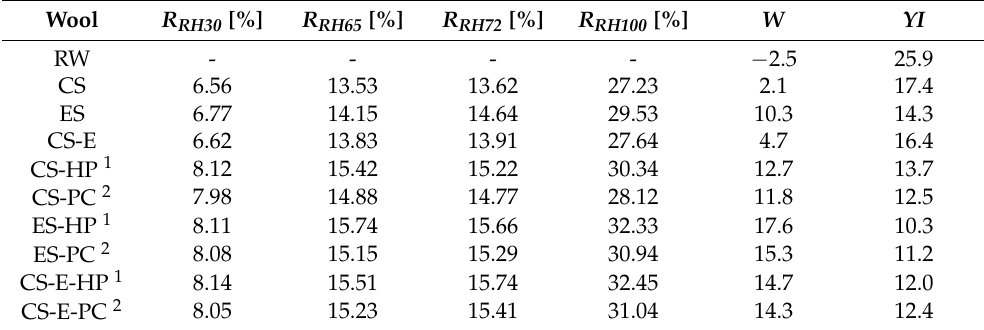
Table 4. The moisture content (regain, R) at different RH (30, 65, 72 and 100%), degree of whiteness (W) and yellowing index (YI) of raw, scoured and bleached wool.